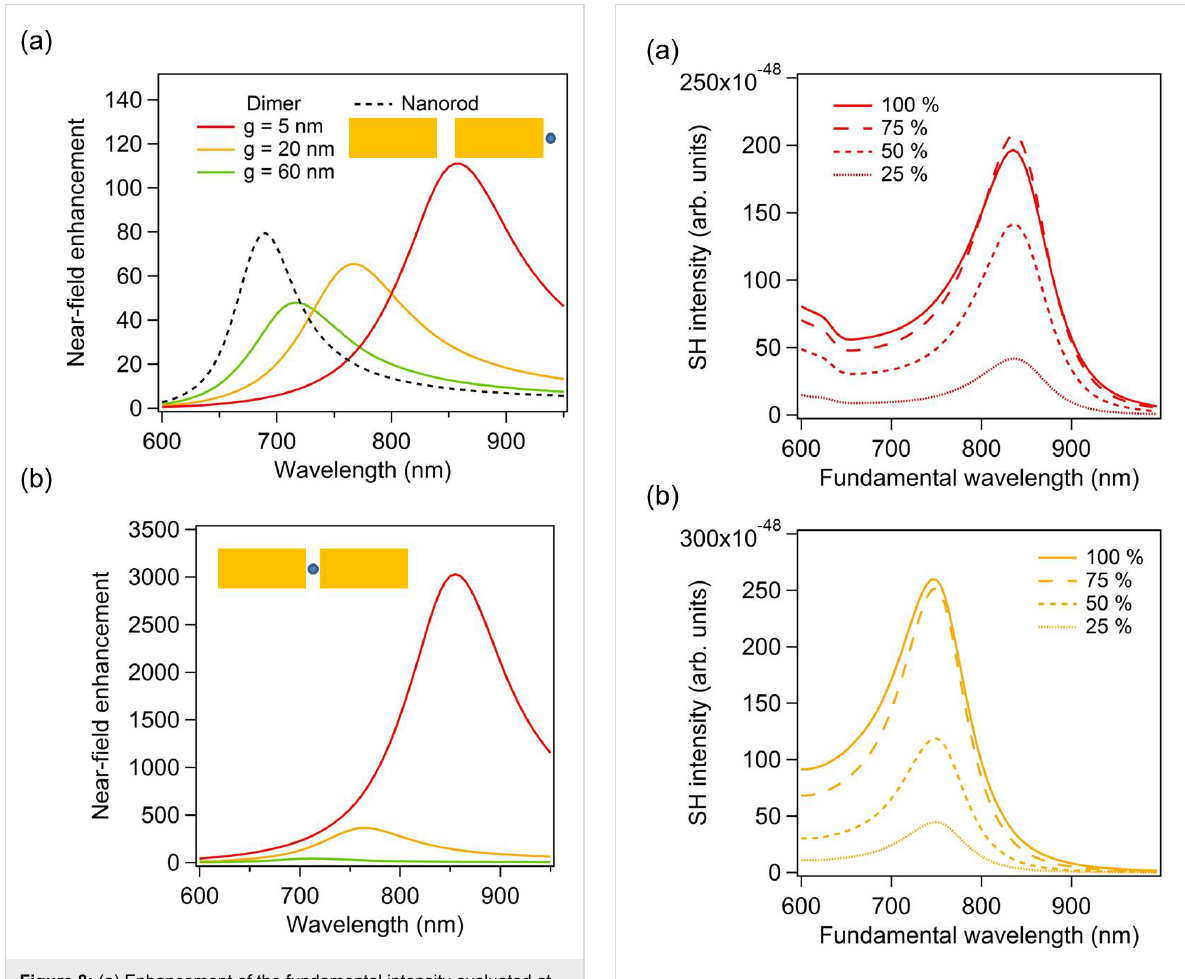
Figure 8: (a) Enhancement of the fundamental intensity evaluated at the nanorod extremities (2.5 nm away from the surface) as a function of the wavelength for nanodimers with gaps g = 5 nm, 20 nm, and 60 nm as well as for a single nanorod. (b) Enhancement of the funda- mental intensity evaluated at the gap center as a function of the wave- length for nanodimers with gaps g = 5 nm, 20 nm, and 60 nm as well as for a single nanorod. The field enhancement is evaluated at 2.5 nm away from the nearest surface.